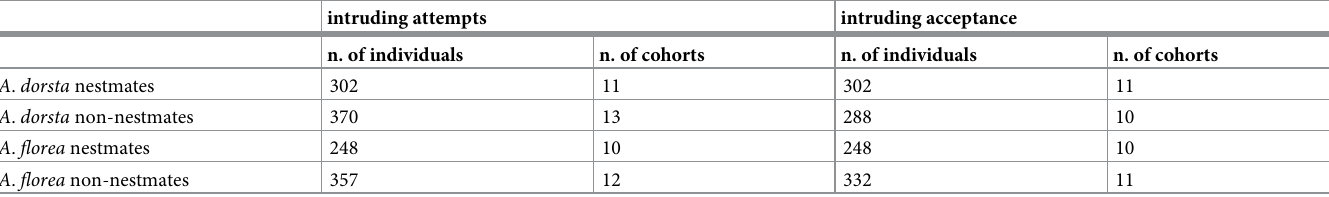
Table 1. Sample size for intruder